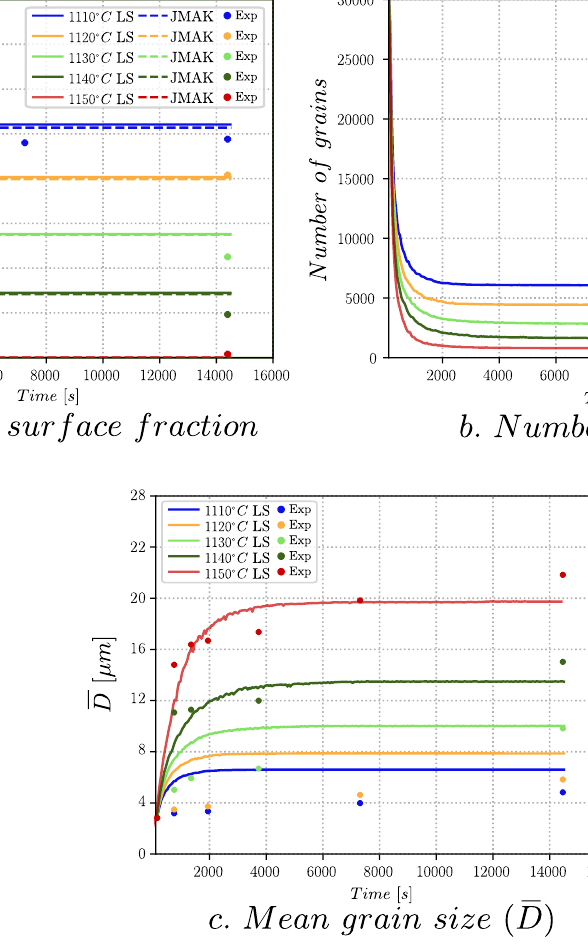
Figure 18. Simulation results for the N 19 superalloy taking into account both the evolving primary γ (cid:48) phase and the static PPB